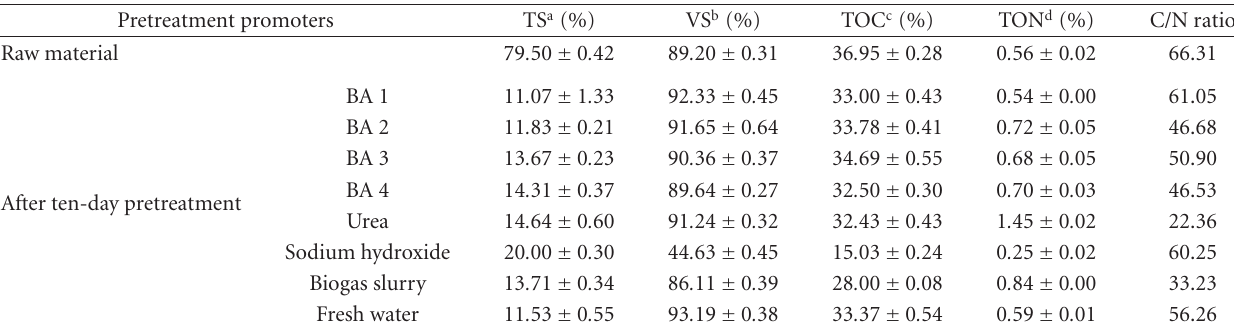
Table 1: Basic characteristics of maize straw before and after ten-day pretreatment.